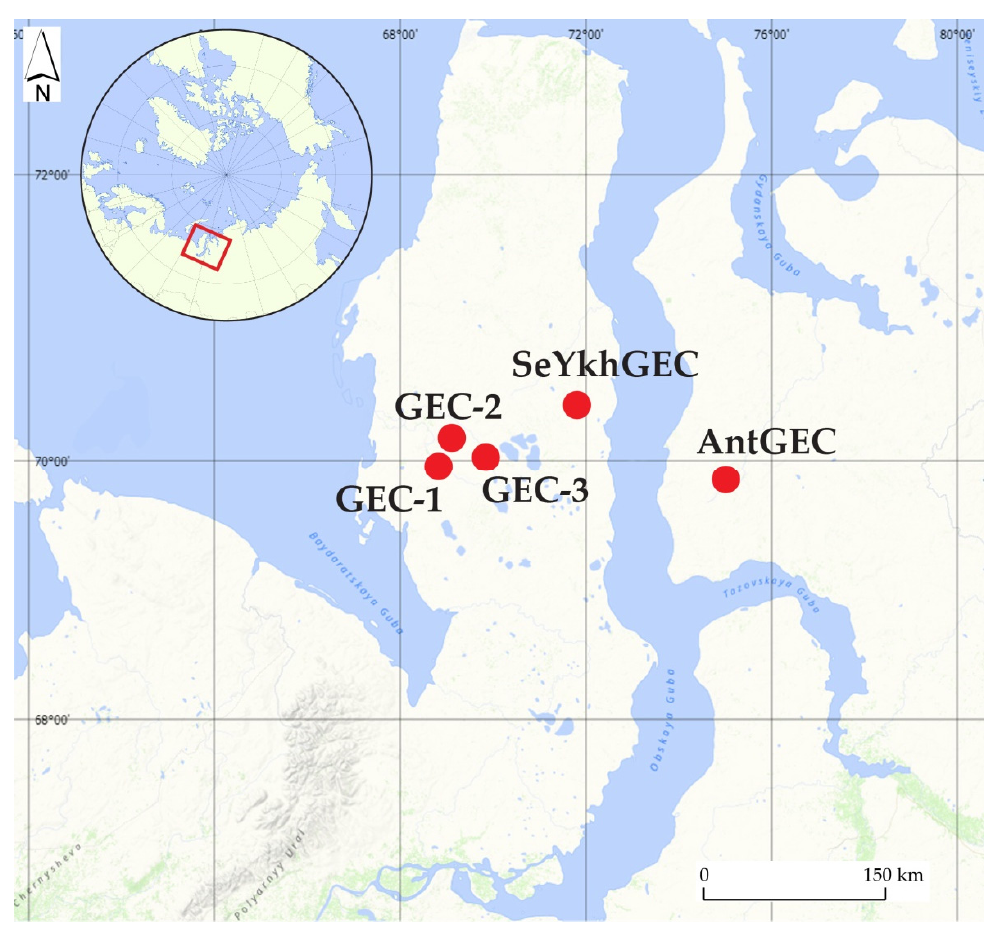
Figure 1. Gas emission craters location map.